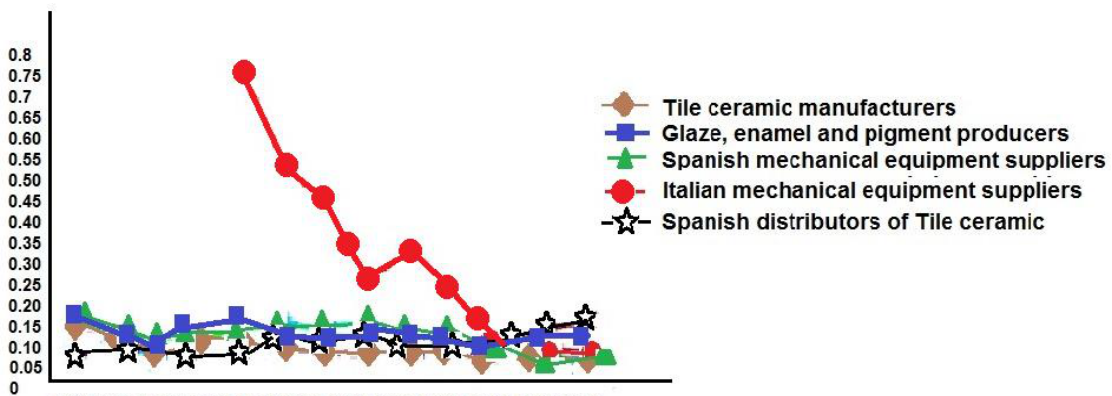
Figure 4. Operating profit on assets